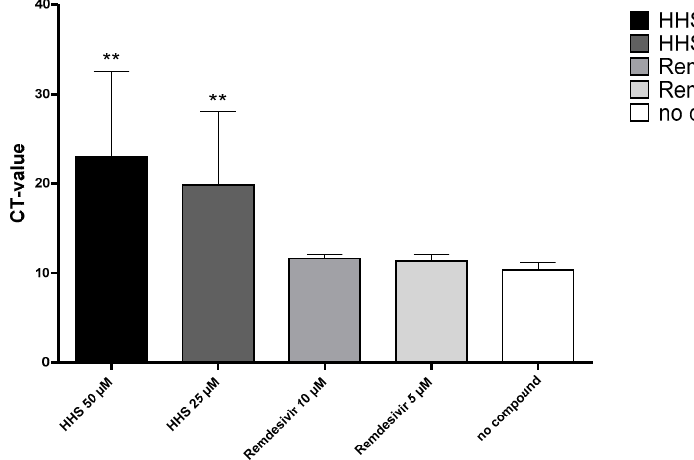
Figure 6. Incubation of VeroE6 cells with HHS and remdesivir for one hour in parallel to virus